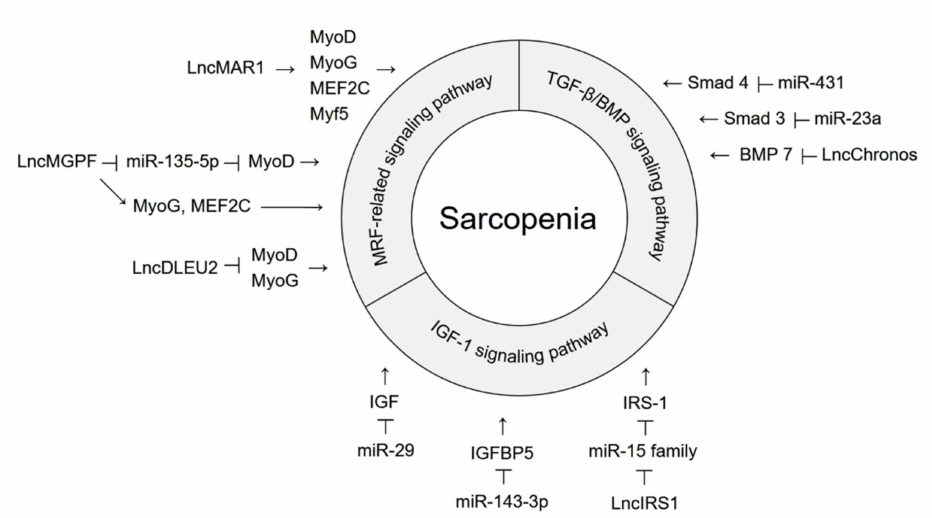
Figure 2. Non-coding RNA-mediated signaling pathways in sarcopenia. The TGF- β /BMP signaling pathway is mediated by miR-431, miR-23a, and lncChronos. miR-29, miR-143-3p, and lncIRS1 are involved in the IGF-1 signaling pathway. LncMAR1, lncMGFP, and lncDLEU2 are involved the MRF-related signaling pathway. Arrow indicates activation of expression; lines with a perpendicular line at the end indicate inhibition of